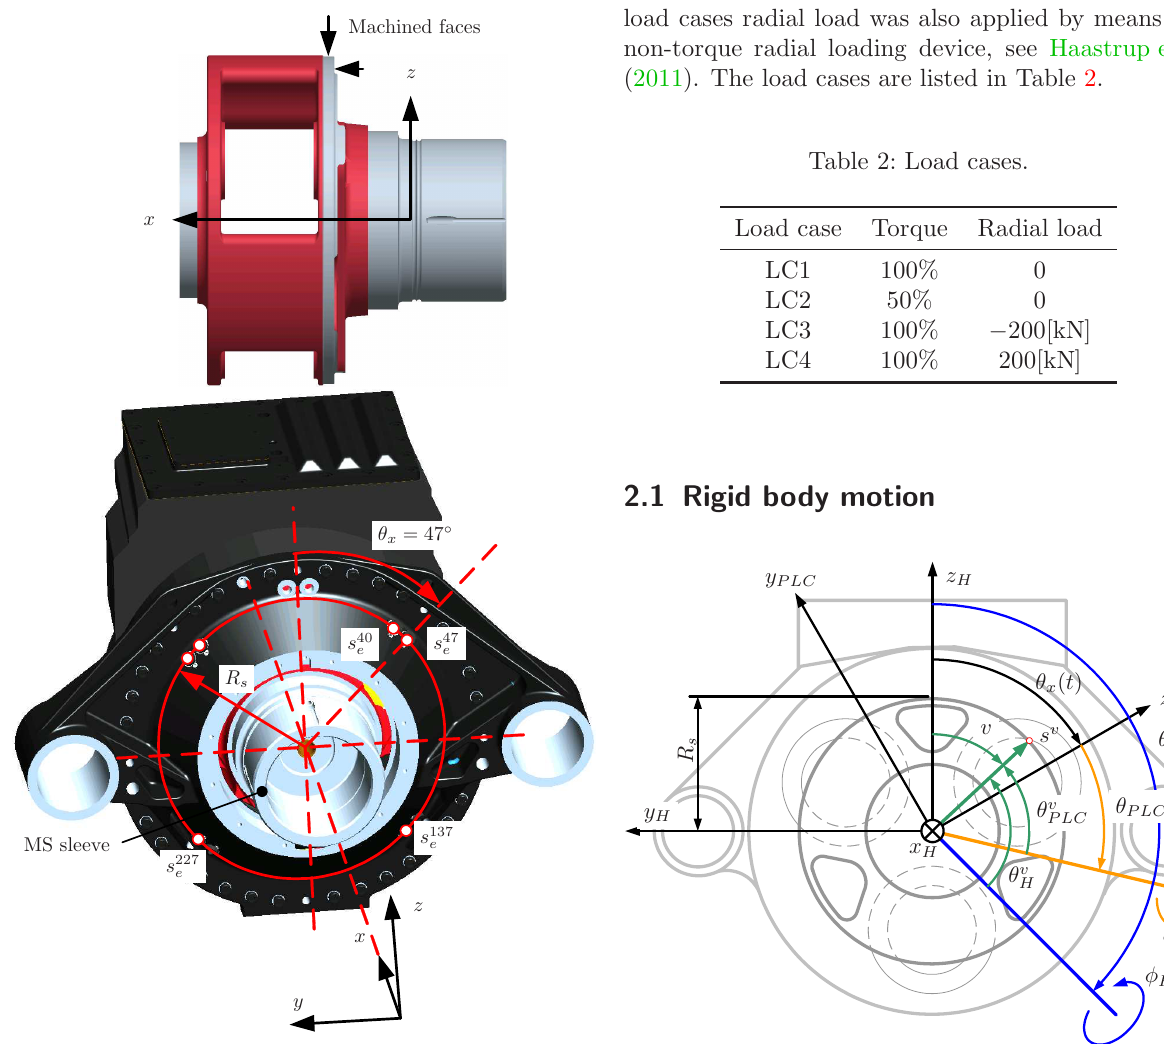
Figure 2: CAD drawing showing the location of the proximity sensors.